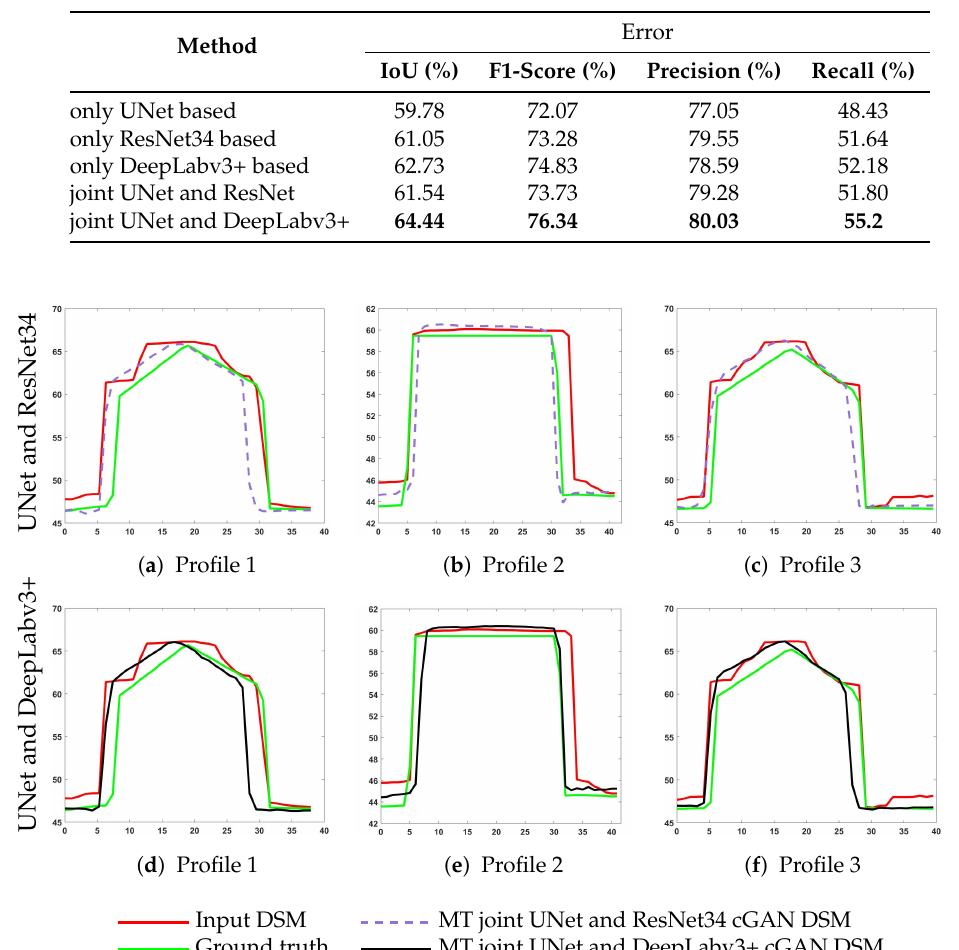
Figure 10. Illustration of the profiles for three selected buildings (cf. Figure 3c) from DSMs generated by ( a – c ) the two-stream generator network jointly trained UNet and ResNet34 architectures for multiple tasks and ( d – f ) the two-stream generator network jointly trained UNet and DeepLabv3+ architectures for multiple tasks. The results are generated by the two-generator, two-output network depicted in Figure